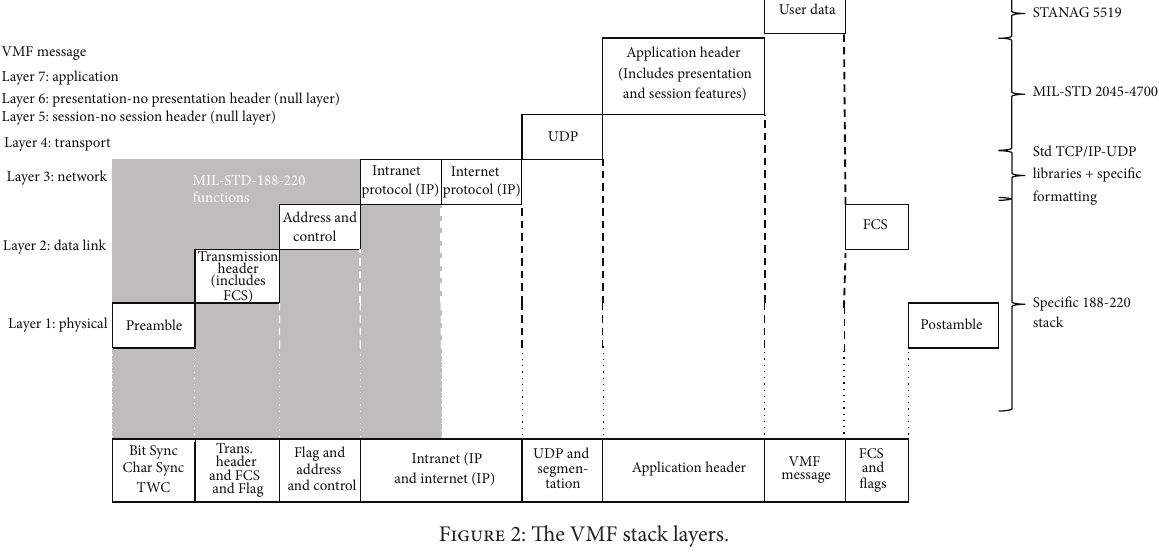
Figure 2: The VMF stack layers.